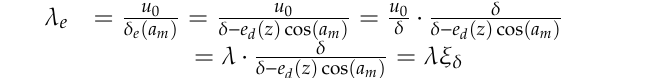
Figure 2. ( a ) Magnet gap deformation of the in-wheel motor (IWM) (air-gap exaggerated) and ( b ) the winding distribution of the permanent magnet brushless direct contact (PMBDC) motor.